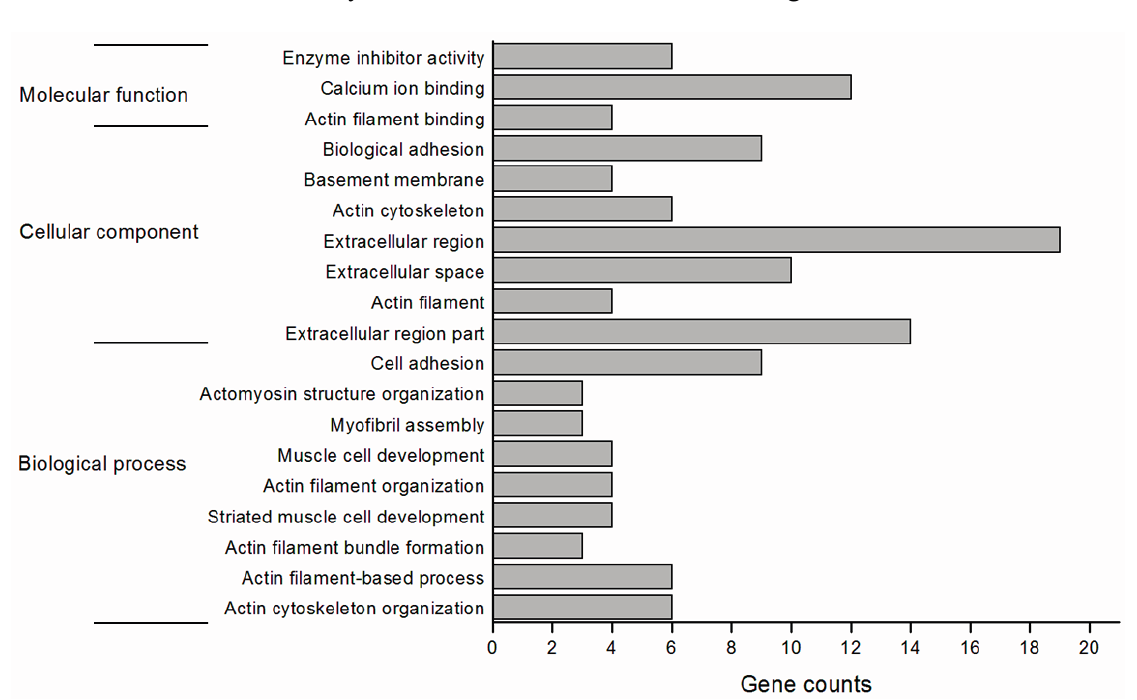
Figure 3. Overview of enriched gene ontology functional classifications of muscle differential expression genes between MSTN propeptide transgenic and wild-type